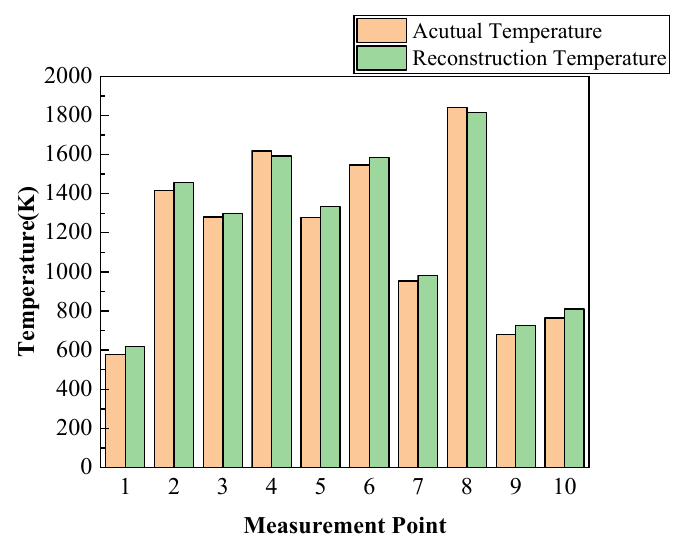
Figure 11. Comparison between Reconstructed Temperature and Actual Temperature of 10 points.